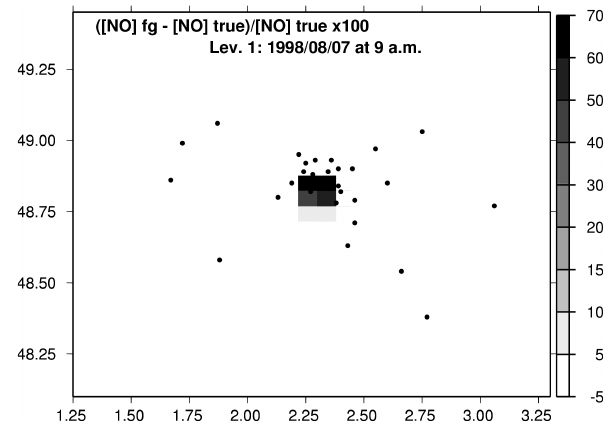
Fig. 5. Evolution of the norm of the gradient through the opti- mizer’s iterations for k-cases using NO constraints with the first- guess inventory +50% and (cid:15) m = 10% (converging) or (cid:15) m = 0% (non-converging).